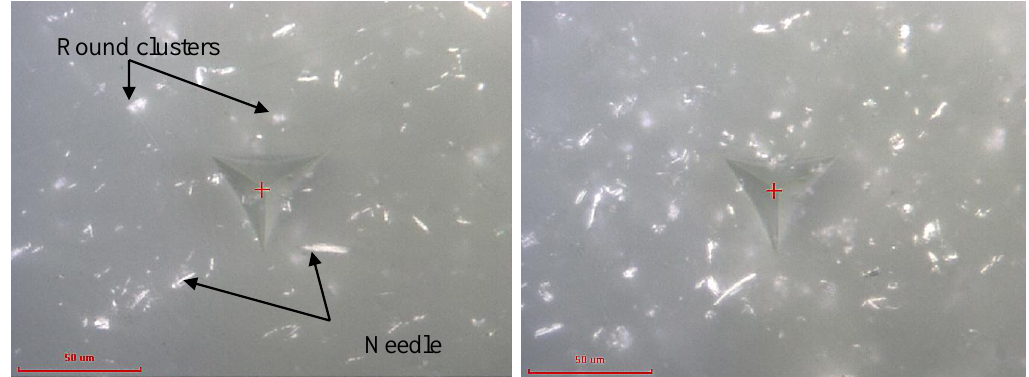
Figure 9. Micrographs of the indentation site of 2 wt % CNP filled epoxy, representing indentation at or near CNP clusters.